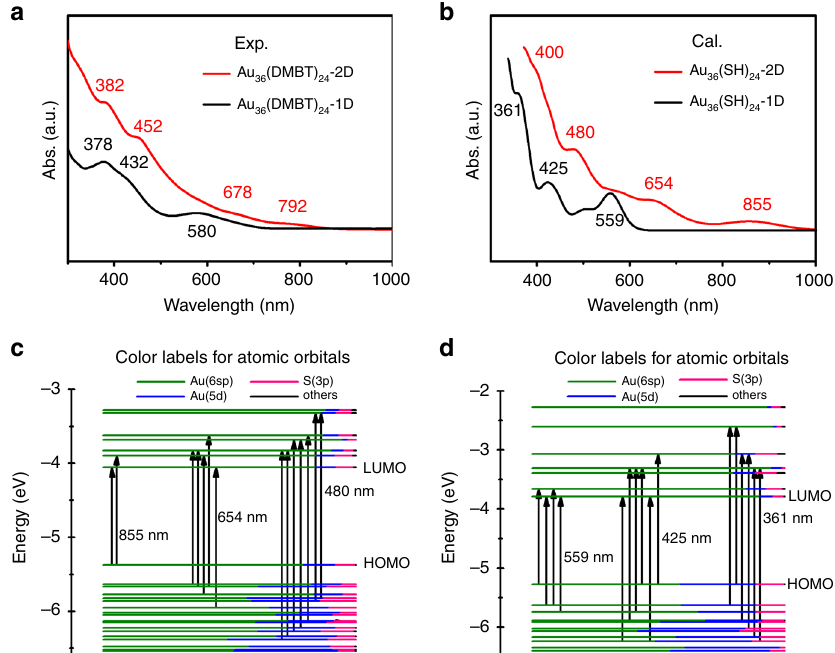
Fig. 2 The optical absorption properties of Au 36 (DMBT) 24 nanoclusters. a Experimental UV-vis spectra of Au 36 (DMBT) 24 -2D and Au 36 (DMBT) 24 -1D. b Calculated UV-vis spectra of Au 36 (SH) 24 -2D and Au 36 (SH) 24 -1D. The values in the black or red are the wavelength (nm) corresponding to the absorption peaks. Molecular orbital (MO) energy level diagrams for c Au 36 (SH) 24 -2D and d Au 36 (SH) 24 -1D. The energies are in eV. Various colors are used to mark relative contributions (line length with color labels) of different orbitals. The major orbital contributions from the Au(6sp), Au(5d), and S(3p) are in olive, blue, and pink, respectively. The values in the black are the wavelength (nm) corresponding to the absorption peaks.